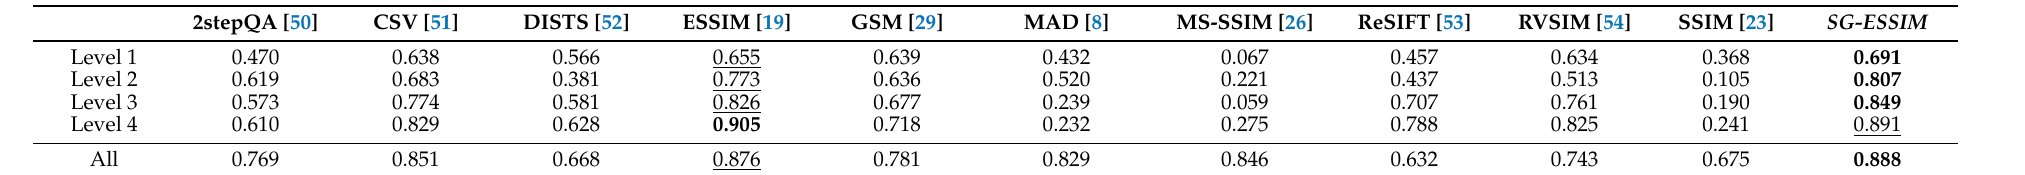
Table 9. Comparison of SROCC for each FR-IQA metric on TID2008’s [21] distortion levels (Level 1 represents the lowest level of degradation, while Level 5 represents the highest one). The highest values are typed in bold , while the second highest ones are